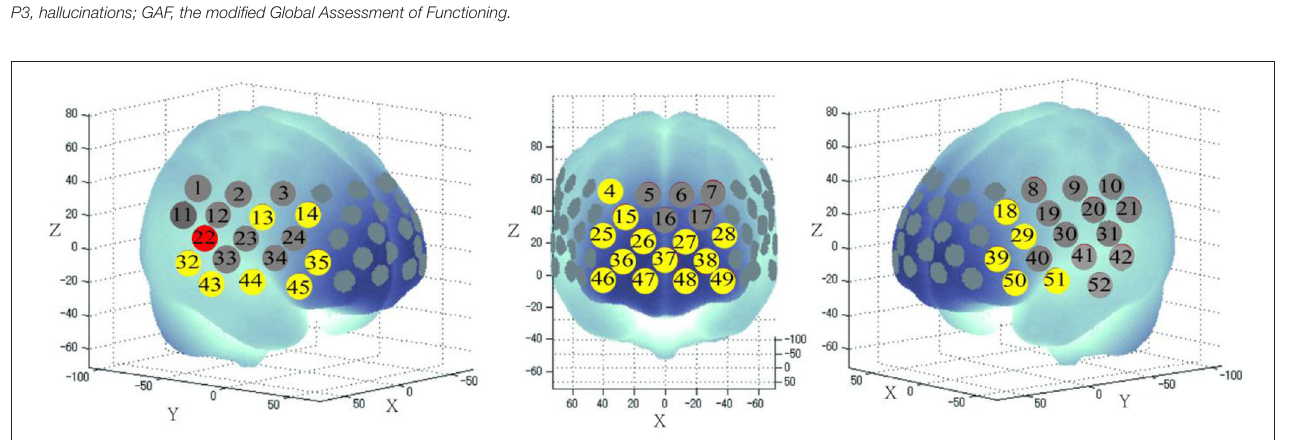
FIGURE 1 | Three-dimensional cerebral maps of oxy-hemoglobin response patterns during the task periods. The red and yellow colors of 26 channels exhibit significant changes in mean 1 β values of oxy-hemoglobin during the VFT task period among the three groups, as determined using one-way ANOVA tests (FDR-corrected p <